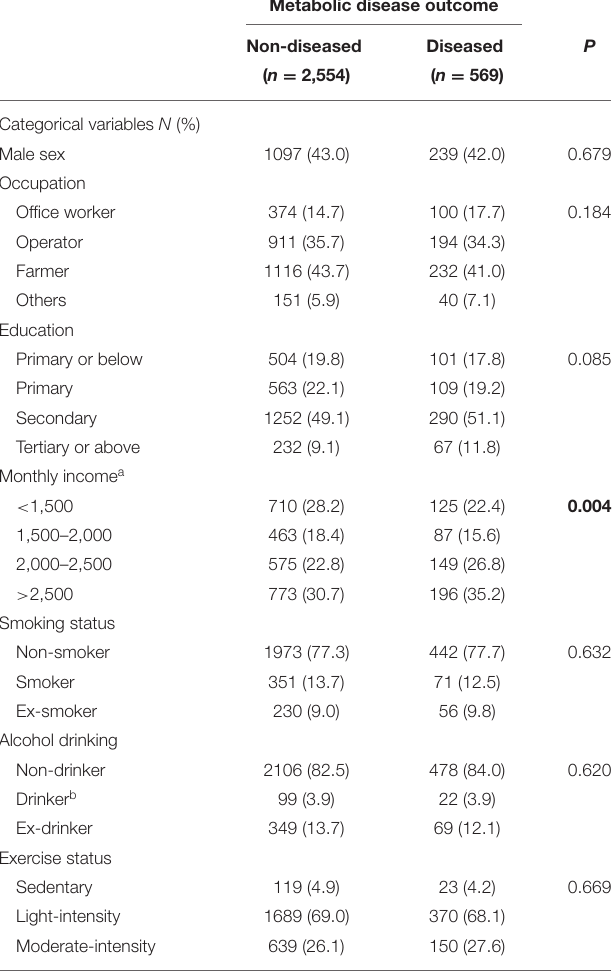
TABLE 1 | Demographic variables associated with cardiometabolic